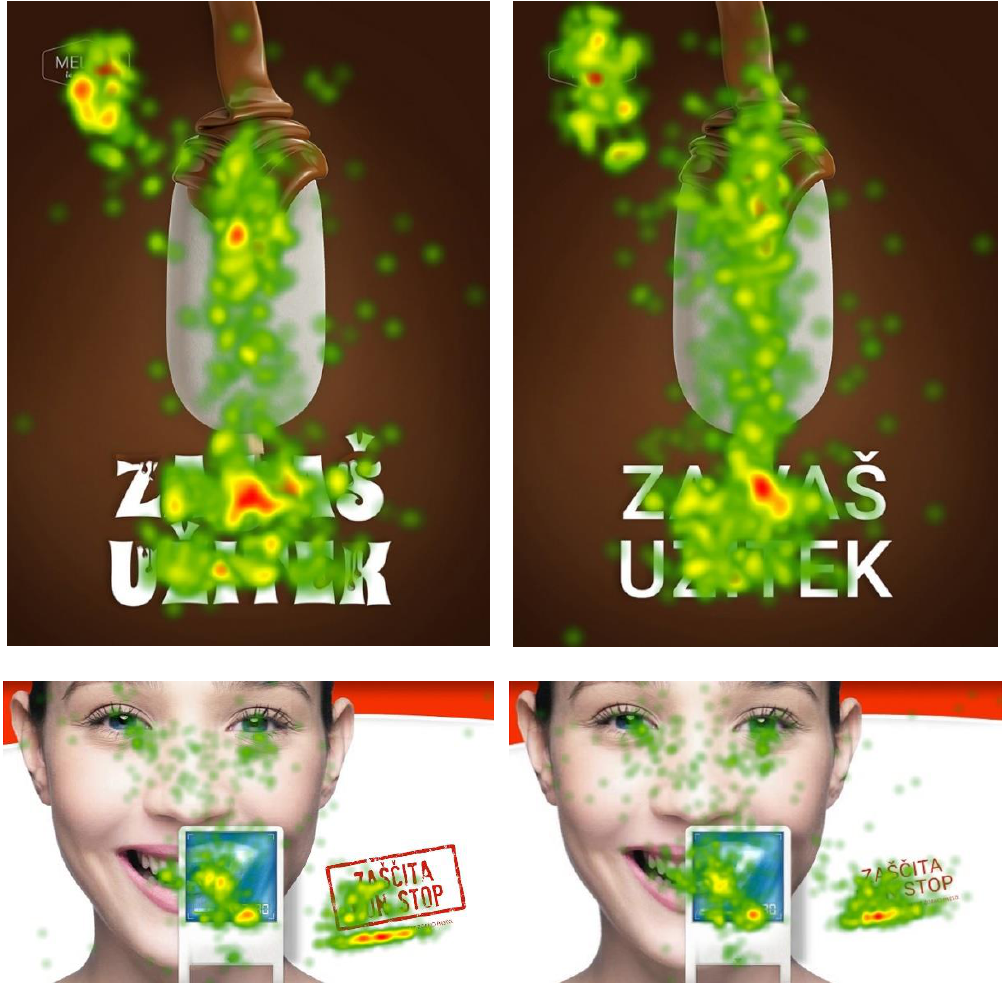
Figure 6. Heat maps comparing the eye movements of the experimental and control group. From left to right: An ad promoting a hedonic product with slogan visually amplified with rhetorical figuration. An ad promoting a hedonic product with slogan visually without rhetorical figuration. An ad promoting a utilitarian product with slogan visually amplified with rhetorical fig- uration. An ad promoting a utilitarian product with slogan visually without rhetorical